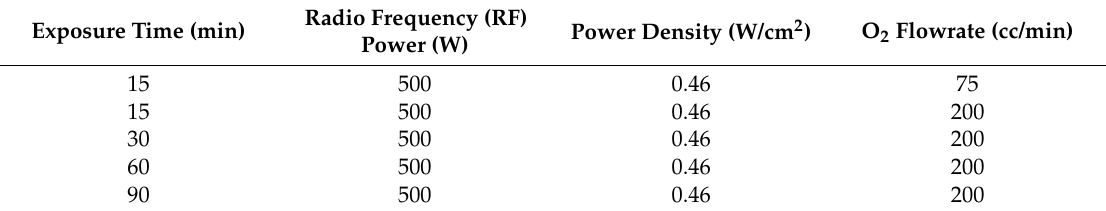
Table 1. Oxygen plasma conditions tested in the PE200RIE machine on greige and scoured yarns. Exposure Time